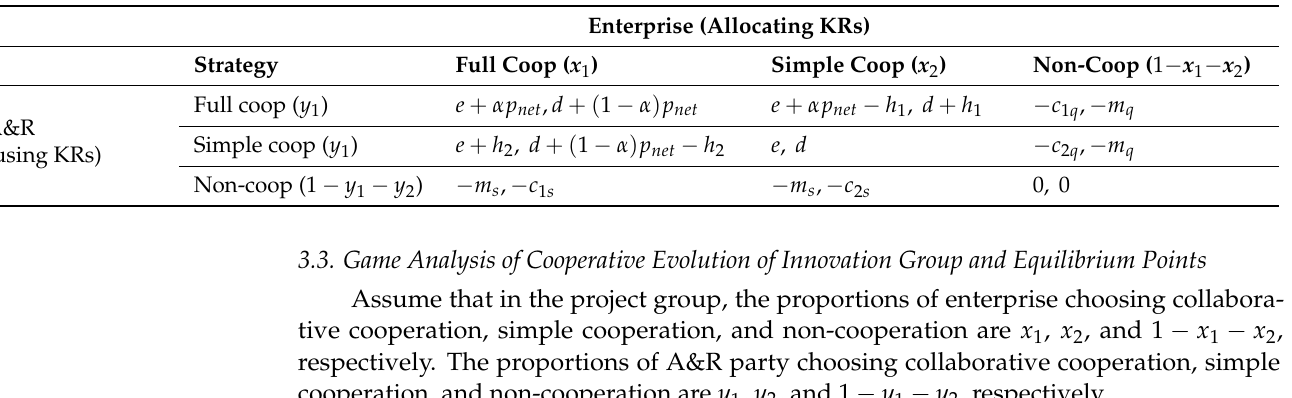
Table 1. Income payout matrix, where the short-hand notations Coll., coop, and KR stand for collaborative and cooperation, key resources,